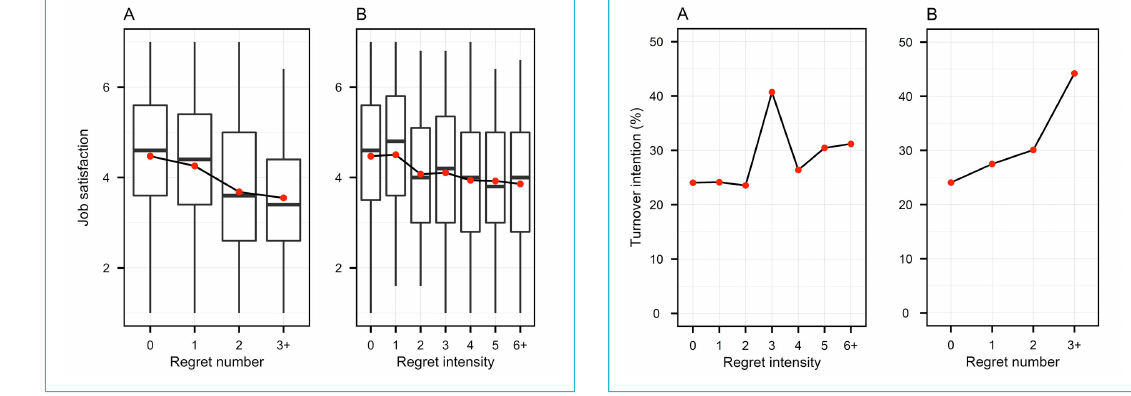
Figure 1: Descriptive results showing the association between re- gret intensity (A) and number of regrets (B) and job satisfaction (on a 7-point Likert scale ranging from 1 to 7 with higher levels indicat- ing higher job satisfaction). Note: mean levels of job satisfaction as a function of regret intensity (A) and number of regrets (B) are shown in red. Boxplots of observed data are shown in grey.